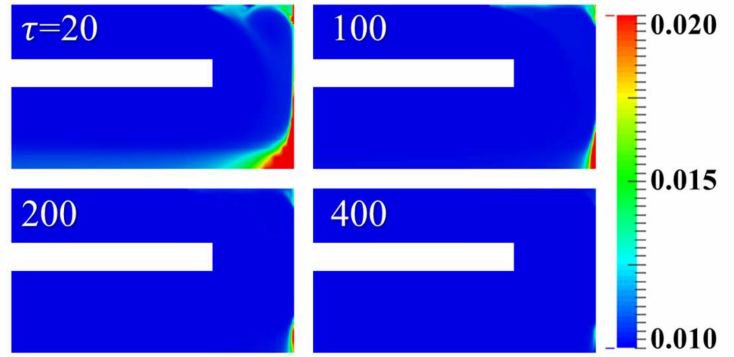
Figure 8. Nanoparticle concentration field near the bottom borehole at different dimensionless time, τ . The Reynolds number is 3686.